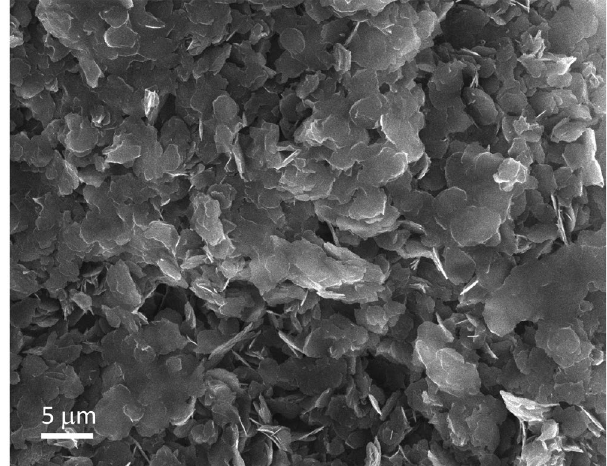
Figure 3. SEM image of LDH-CO 3 precursor after MW